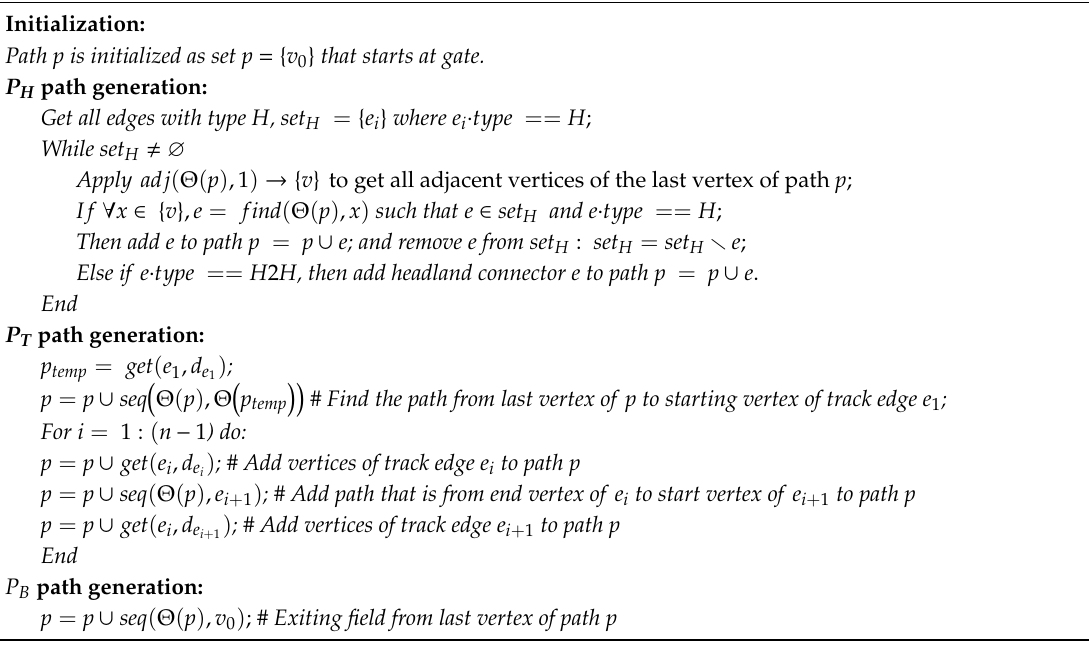
Algorithm 1. Pseudo codes for continuous path